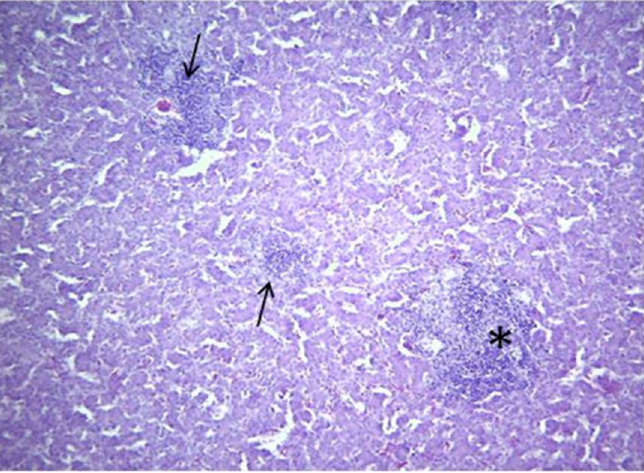
Fig 4. Liver chicken inoculated with FAdV-11 field strain (MOR300315) at 6 dpi -A focus of hepatic necrosis (Asterix) and mixed inflammatory cell infiltrate in the portal spaces (Arrows). H&E, X100.